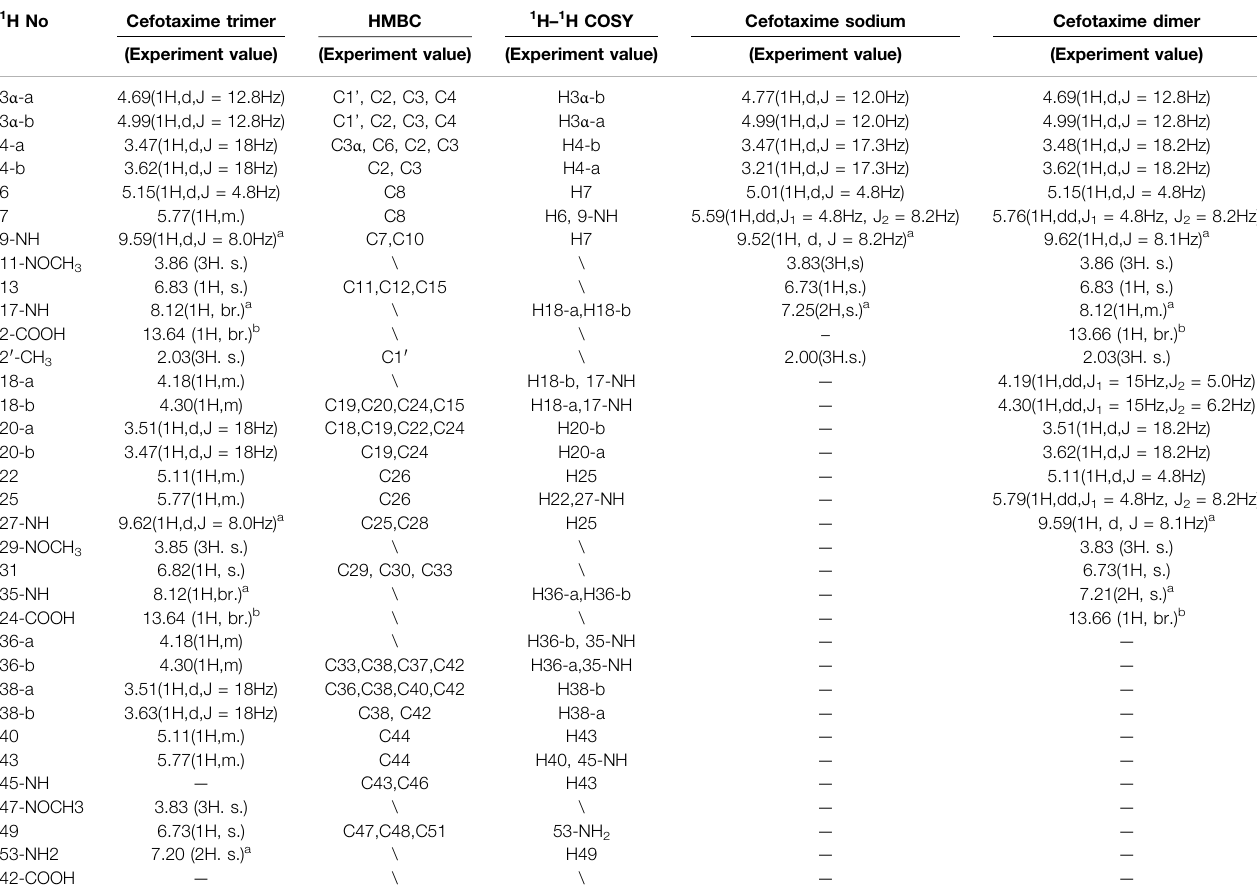
TABLE 4 | 1 H-NMR and 2D-NMR spectra of cefotaxime and cefotaxime